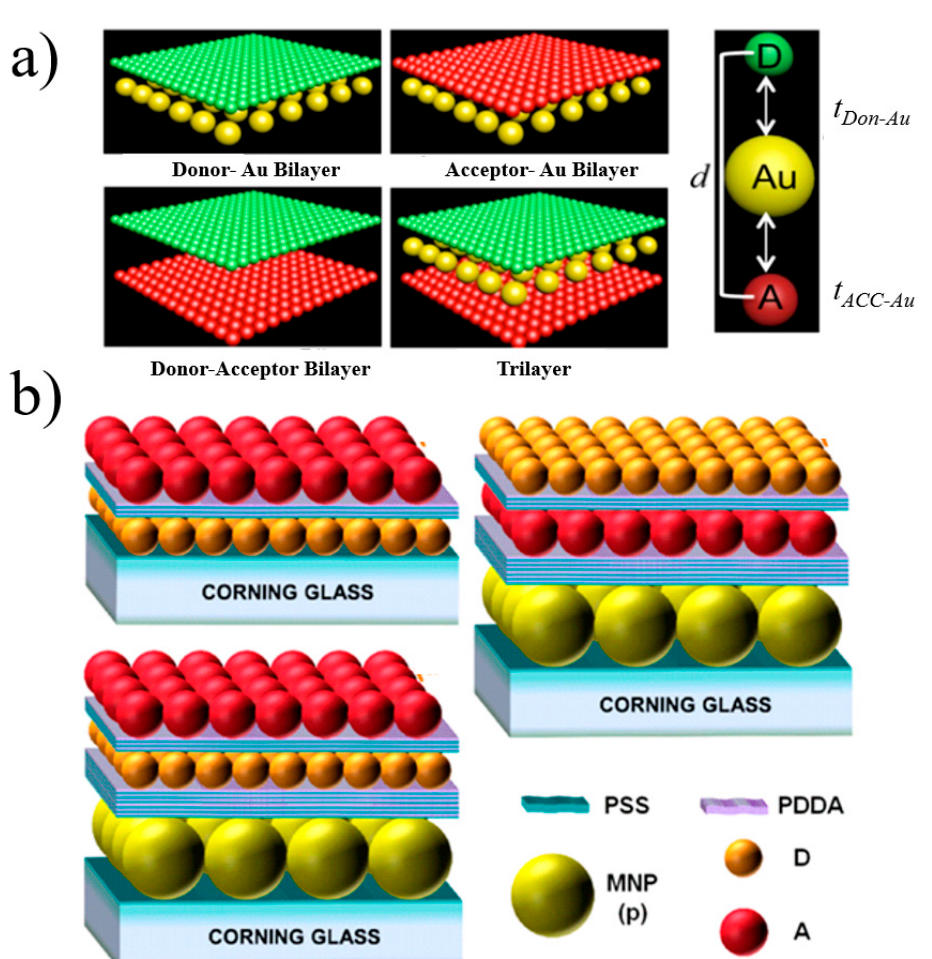
Figure 13. ( a ) Schematics of typical sandwich structures [76]. ( b ) Layered architectures of di ff erent FRET systems [77].